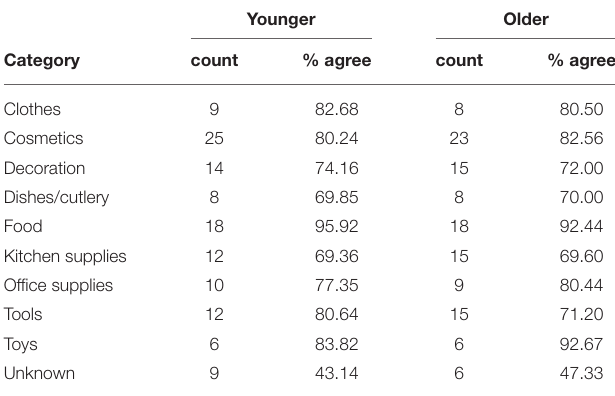
TABLE 3 | Distribution of objects over the categories for younger and older